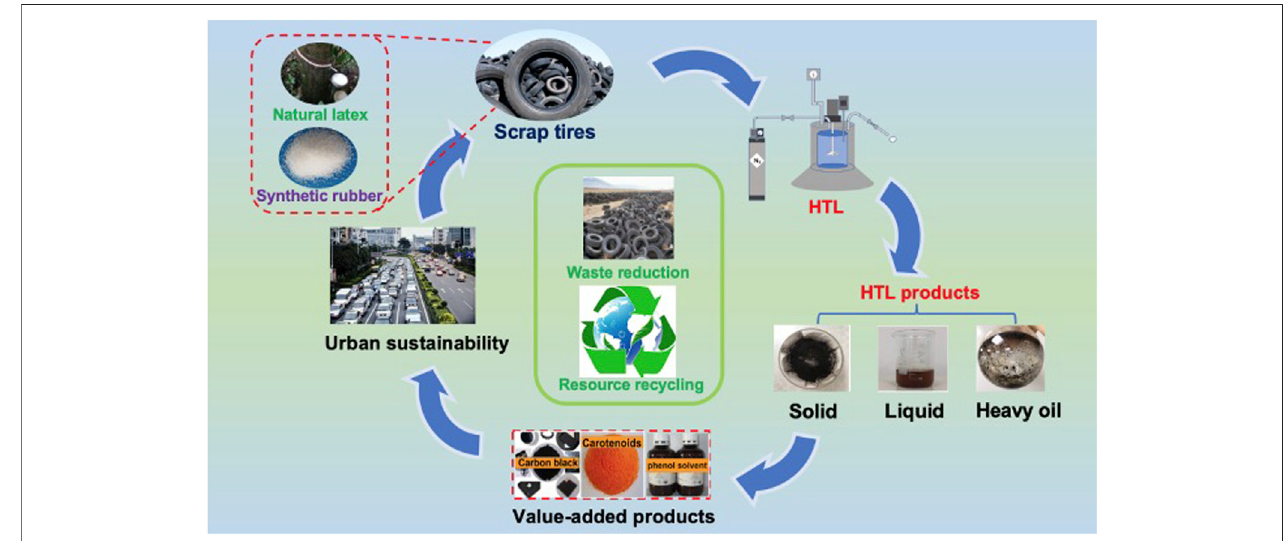
FIGURE 1 | Schematic diagram of the tire recycling process and concept through hydrothermal